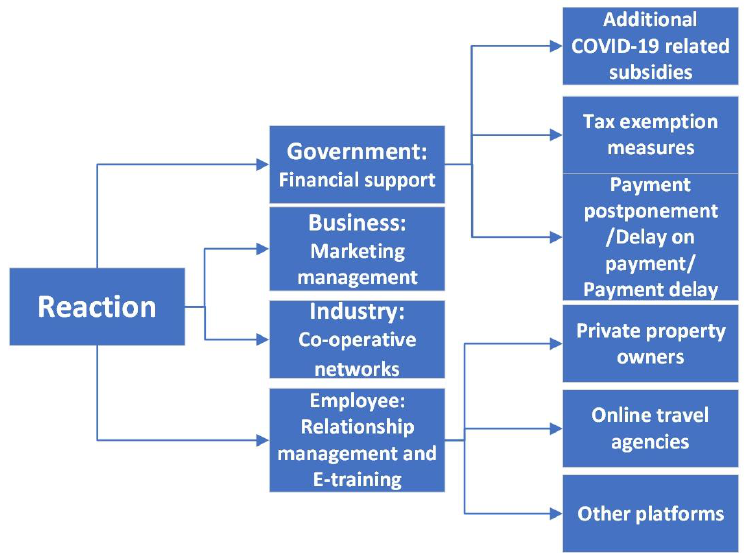
Figure 3. Reactions for reducing the influence of COVID-19 on the hospitality and tourism indus-